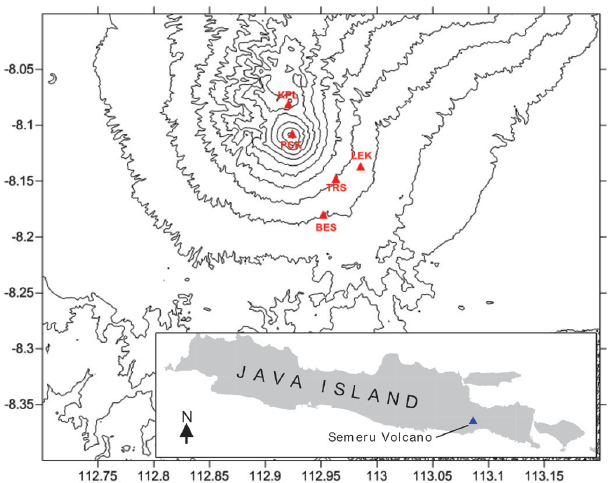
Fig. 1. Topographic map of Mt Semeru volcano showing the loca- tions of seismic stations. The inset at the bottom of the image shows the location of Semeru on the island of